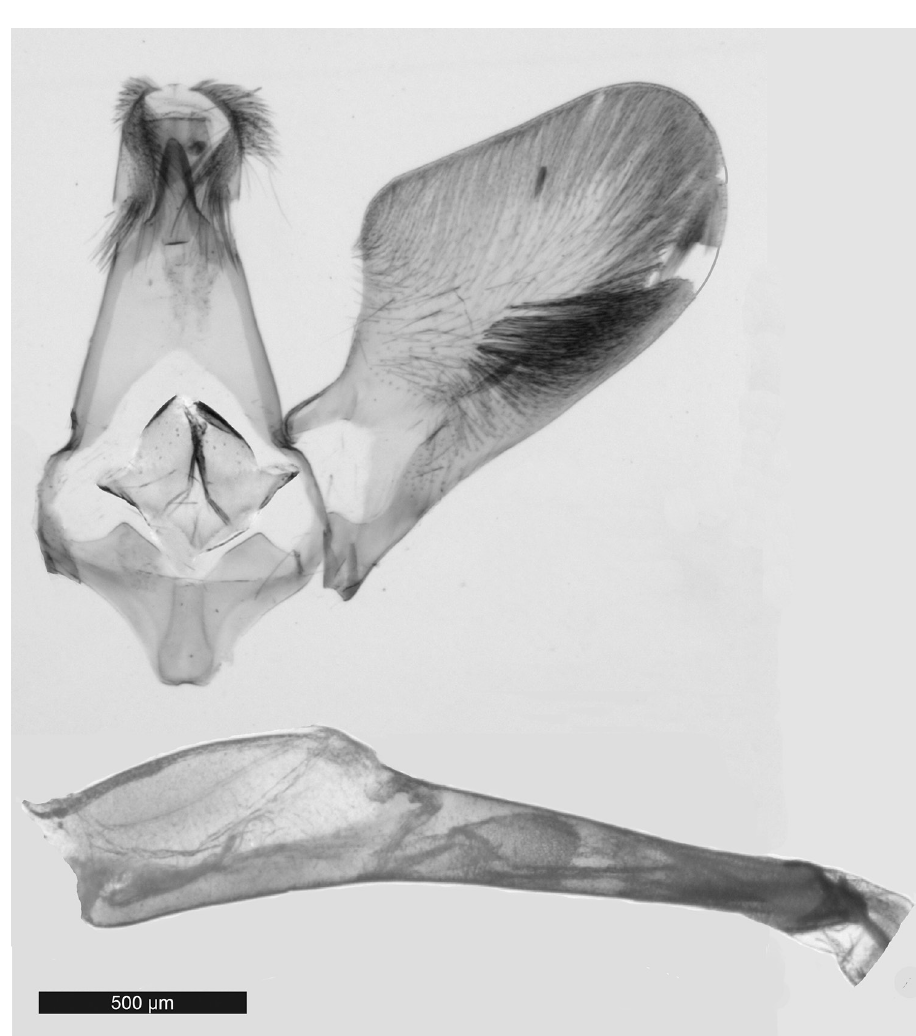
Figure 4. Male genitalia of Pyrophleps ellawi .